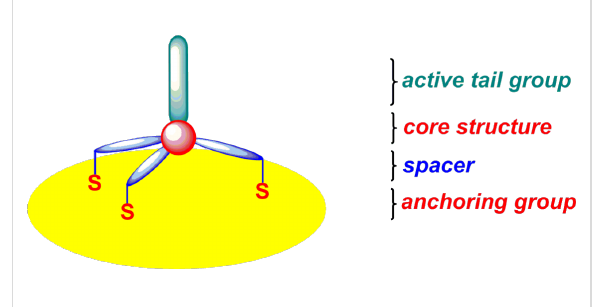
Figure 1: Schematic drawing of a molecule attached to the surface via a tripodal structure.